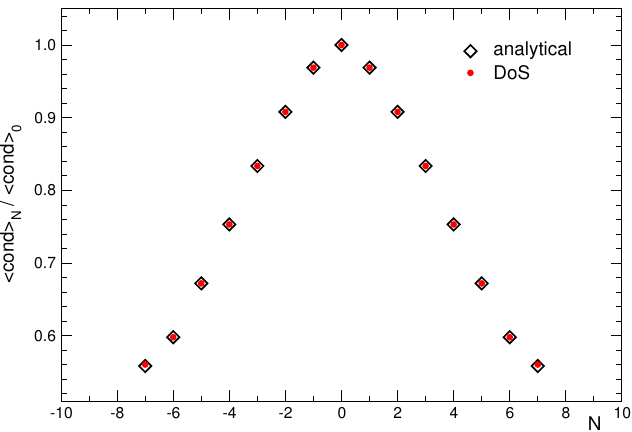
Figure 3. The chiral condensate (cid:104) ψ ( x ) ψ ( x ) (cid:105) N (in the plot denoted as (cid:104) cond (cid:105) N and normalized by the N = 0 value) as a function of the net fermion number N . The parameters are V = 16 × 16 with m = 0.1, and we compare the results from the CanDoS determination (red dots) to the analytic results obtained with Fourier transformation (black